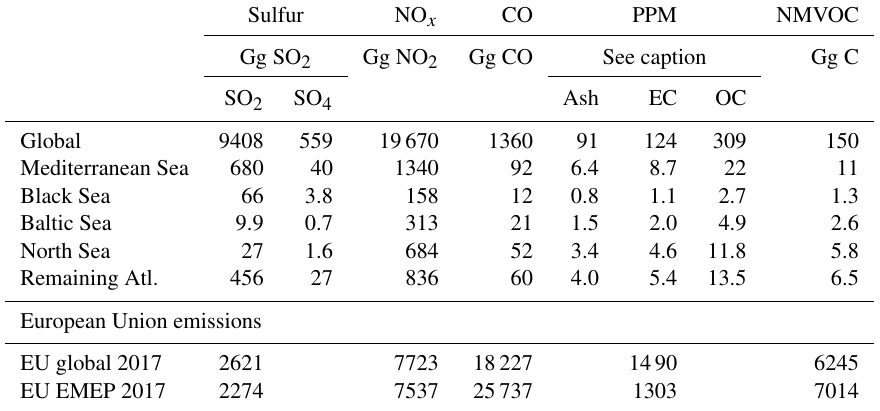
Table 1. Ship emissions from the Finnish Meteorological Institute (FMI) in European sub-sea areas. Sulfur emissions are given as SO 2 . PPM emissions are sub-divided into ash, EC (elemental carbon), and OC (organic carbon), all assumed to be emitted as PM 2 . 5 . Total EU emissions used in global and regional calculations are also listed. A total of 5% of these SO 2 emissions are assumed to be emitted as SO 4 . Sulfur NO x CO PPM Gg SO 2 Gg NO 2 Gg CO See caption SO 2 SO